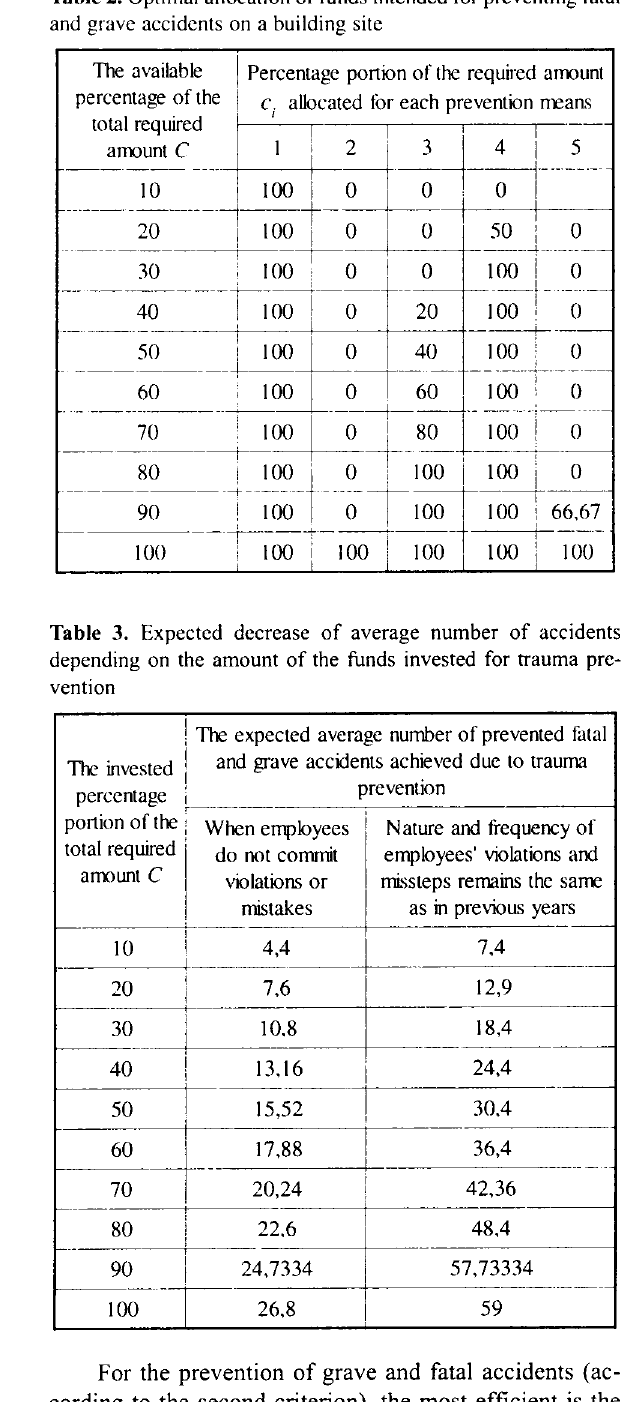
Table 2. Optimal allocation of funds intended for preventing fatal and grave accidents on a building site The available I Percentage portion of the required amount